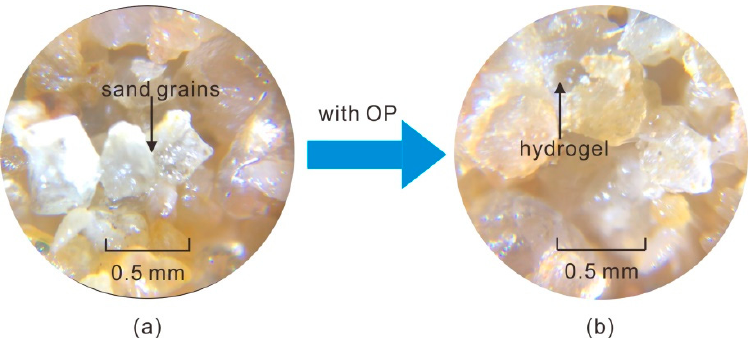
Figure 16. The micro photographs of ( a ) sand and ( b ) OPSS.